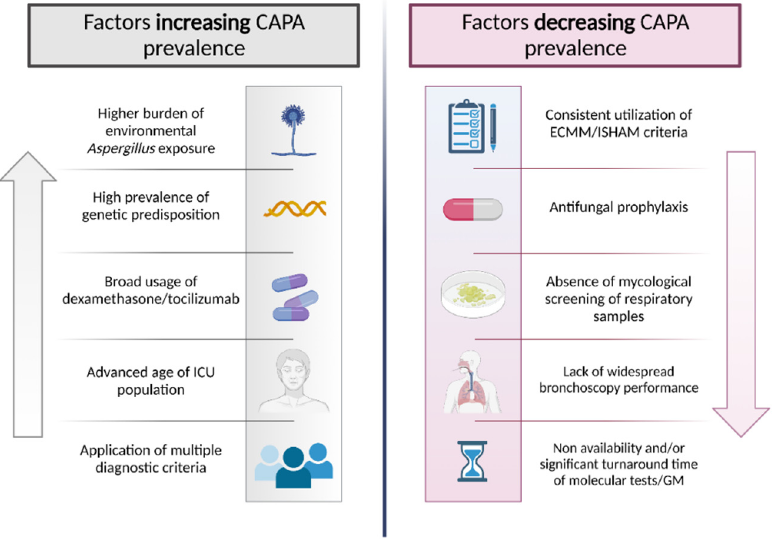
Figure 1. Factors increasing/decreasing prevalence of COVID-associated pulmonary aspergillosis